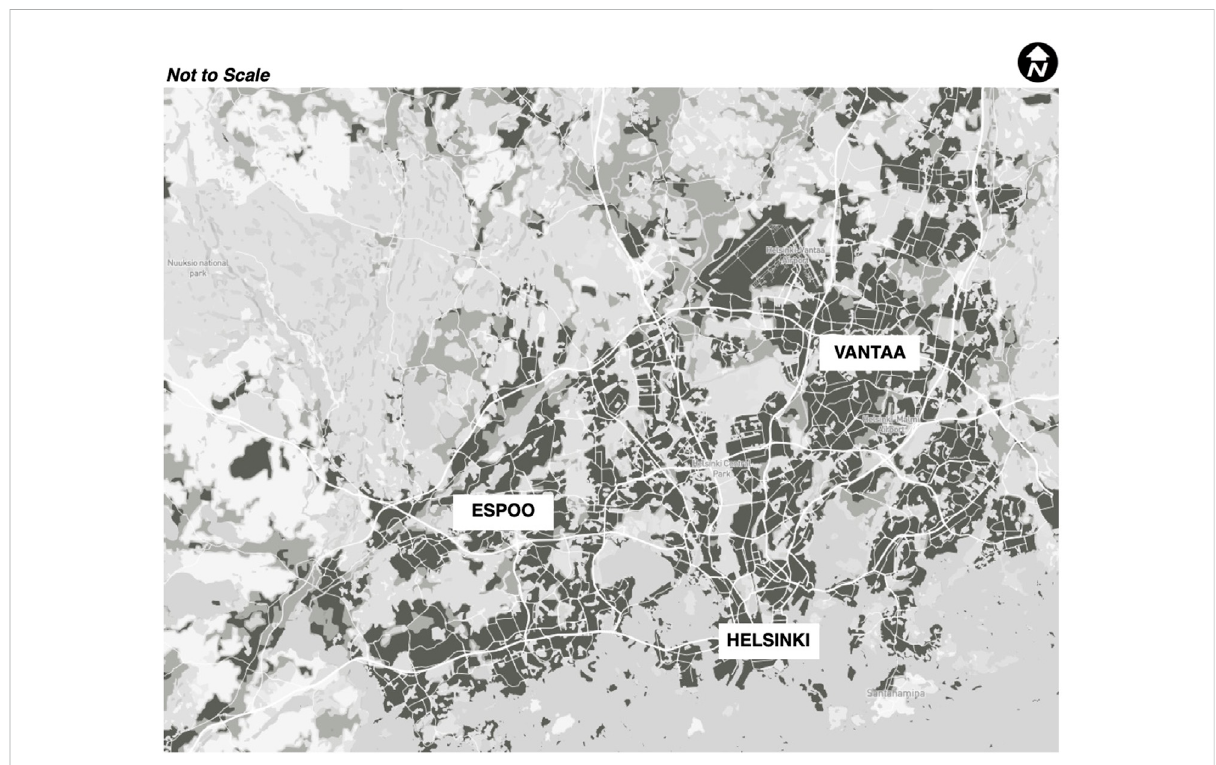
FIGURE 1 Helsinki urban region darker areas indicate urban population density, and lighter areas are less densely populated areas. No density metrics are known, this is a diagram only to show the spatial relationship between the urban areas and the less urban areas only. Source: